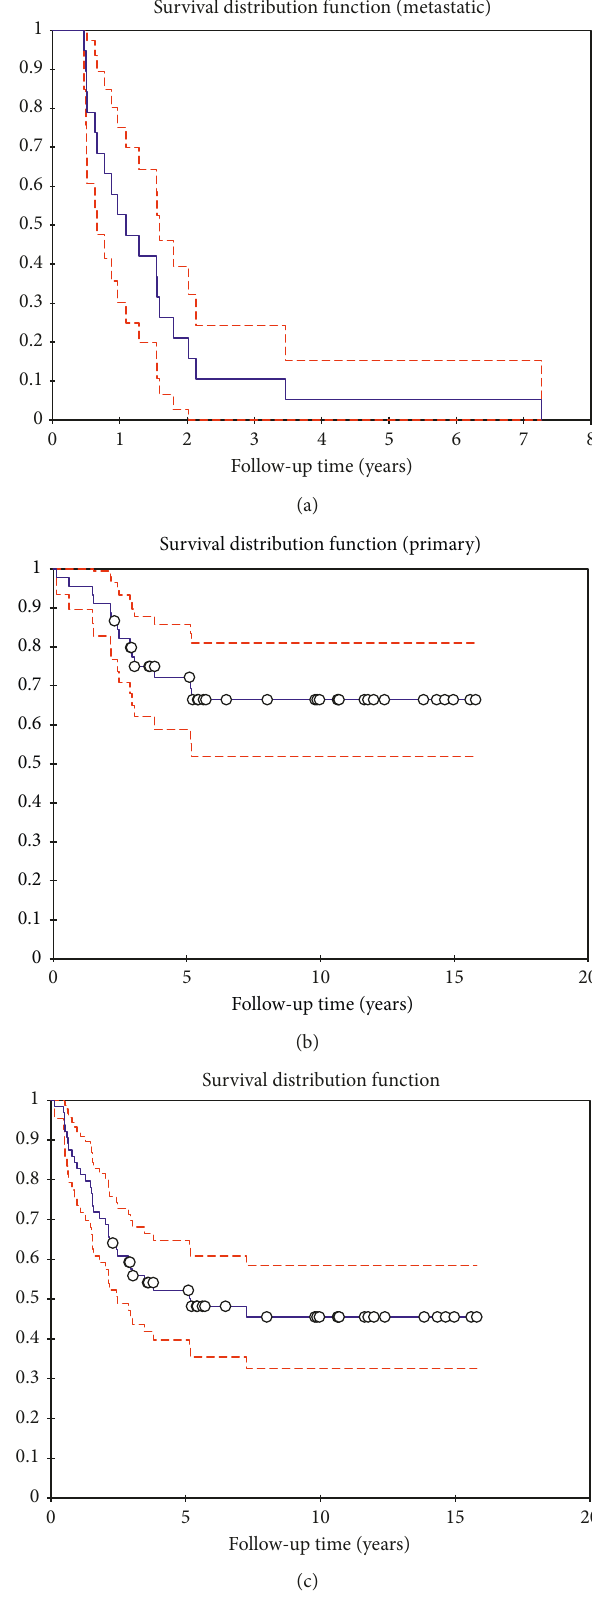
Figure 5: Kaplan–Meier curve survival. OS-curves for (a) patients with synchronous metastatic disease, (b) patients with primary ESFT without metastases, and (c) all patients ( n � 64).